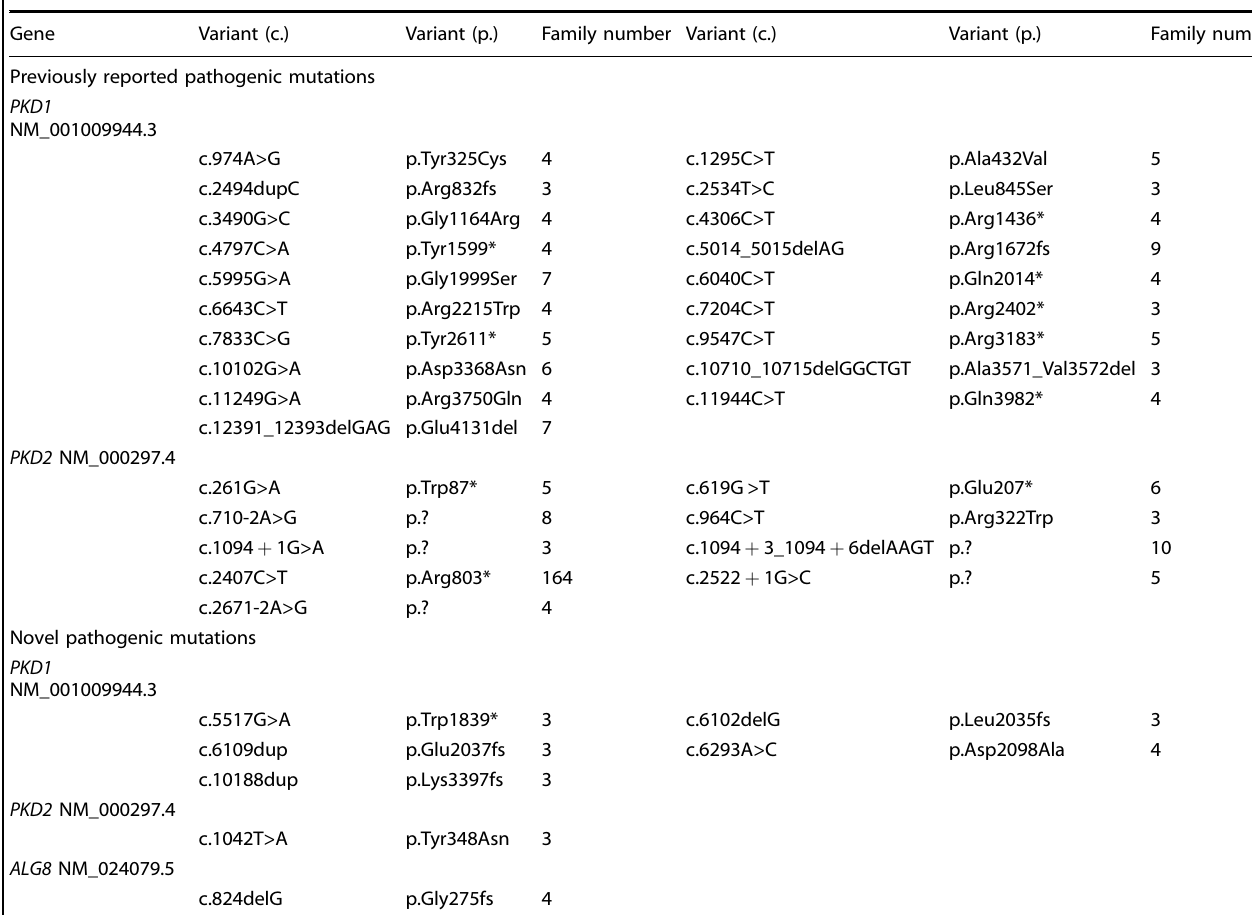
Table 2. Recurrent mutations identi fi ed in Taiwan PKD Cohort. Gene Variant (c.) Variant (p.) Family number Variant